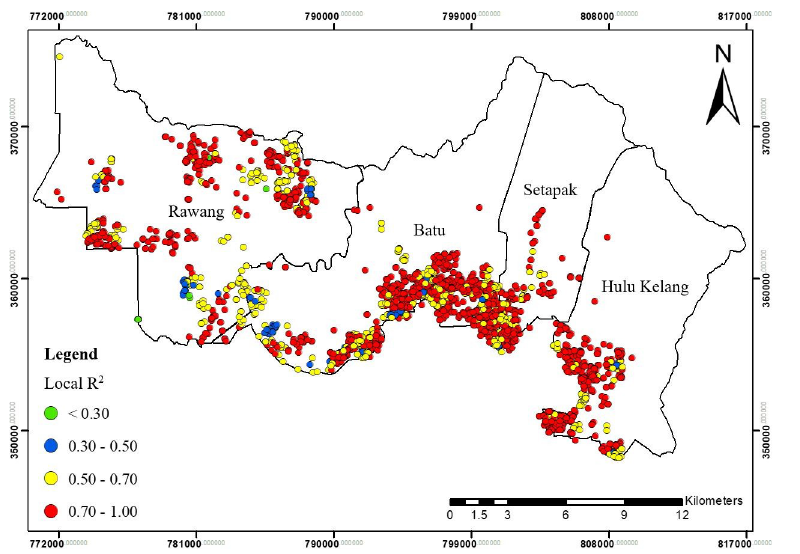
Fig 11. Spatial distribution of local R 2 for GWR2 in Gombak, 2013 to